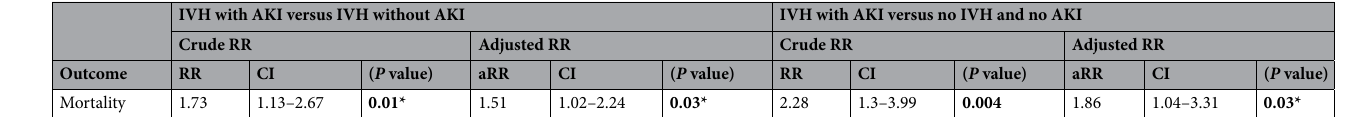
IVH with AKI versus IVH without AKI IVH with AKI versus no IVH and no AKI Crude